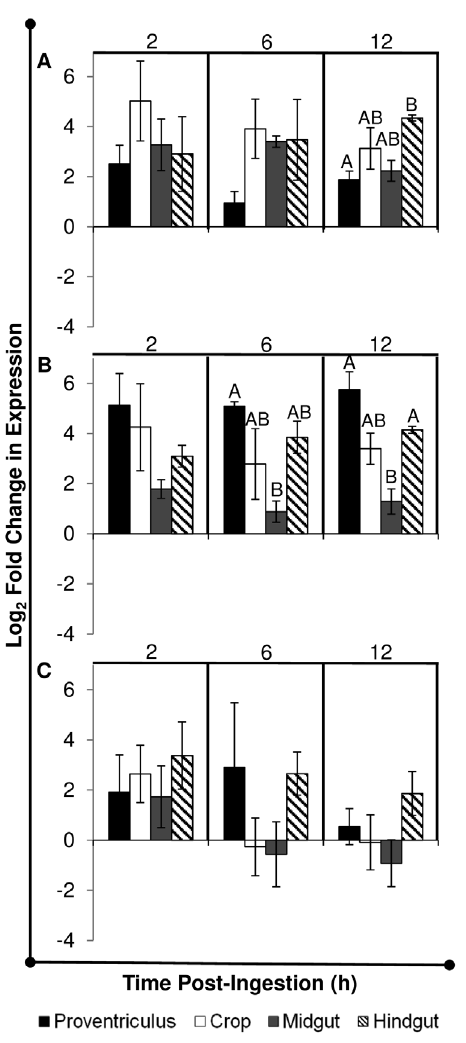
Figure 4. Tissue-specific expression of antimicrobial peptide genes in the alimentary canal of flies that ingested GFP- P. aeruginosa . House flies (n=30 in each of two replicates) were fed an average 6.6 6 10 4 CFU GFP- P. aeruginosa and at 2, 6, 10, 12, and 24 h post-ingestion, flies (n=5 per replicate) were dissected to separate the alimentary canal tissues (proventriculus, crop, midgut, hindgut), which were pooled within replicate/time point for qRT-PCR analysis. Fold changes cecropin (A), defensin (B), and diptericin (C) expression were calculated using the REST-MCS (cid:1) by calibrating to AMP expression levels in unfed adult flies and using the reference gene rps18 . Mean log 2 -fold changes in expression are shown, and error bars are standard error. Different letters represent significant differences between mean AMP expression levels across tissues within the indicated time point (P # 0.05). Refer to Table S3 for REST-MCS analysis of tissue-specific AMP expression for each replicate.